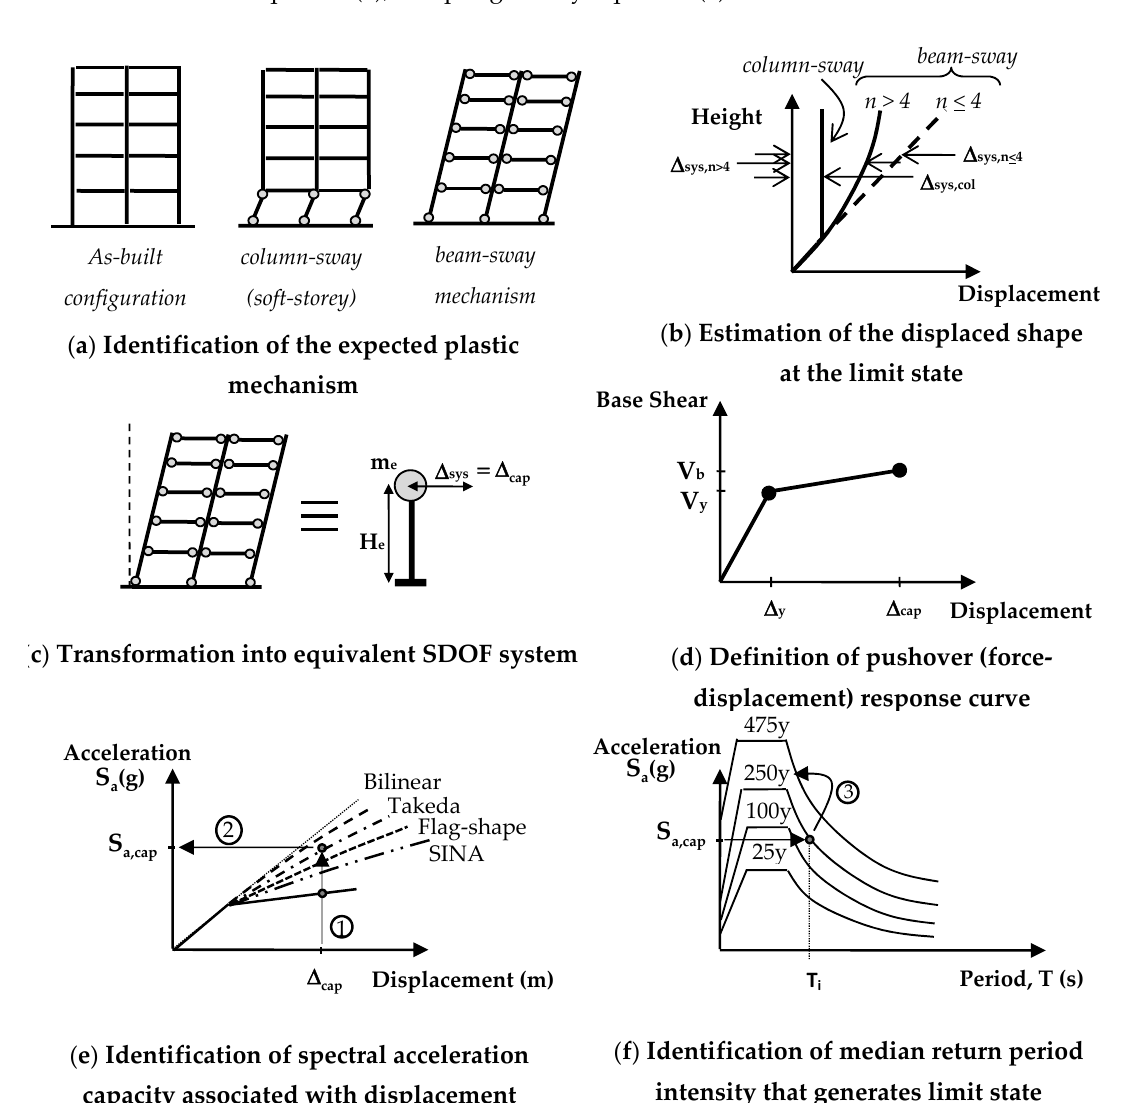
Figure 1. Overview of probabilistic displacement-based assessment approach, Adapted with permission from [12]. Copy- right 2021 Journal of Earthquake Engineering.